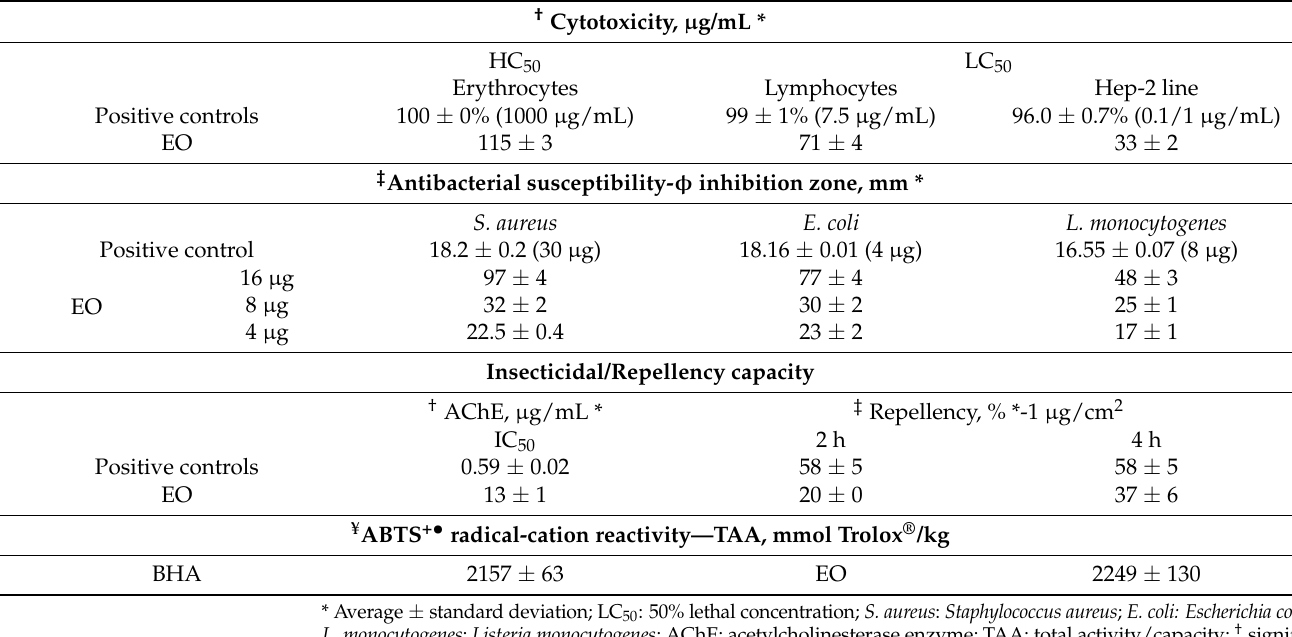
Table 2. Results of the different biological tests applied to the leaf essential oil